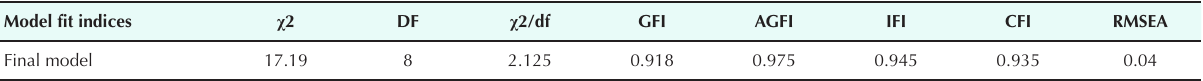
Table 2. Model fit indices Model fit